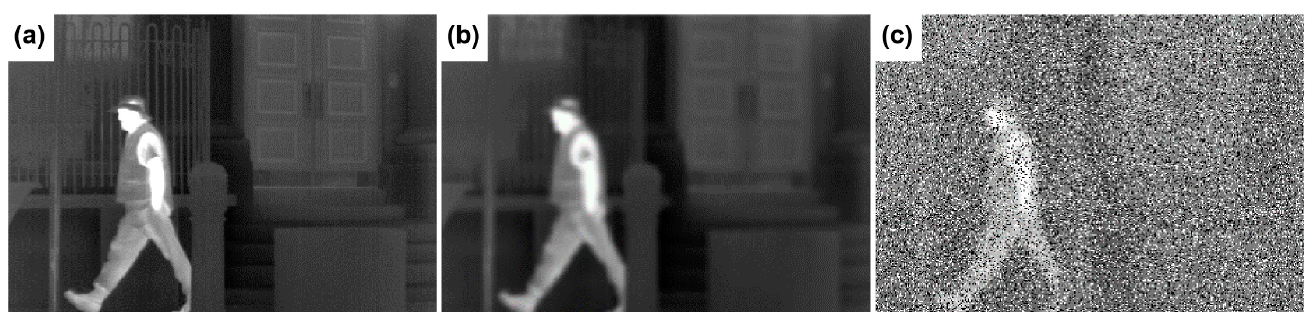
Figure 2. The passerby image with different degrees of degradation. ( a ) The original image, ( b ) the 7 × 7 Gaussian blur, and ( c ) the 7 × 7 Gaussian blur + 30% salt-and-pepper noise.